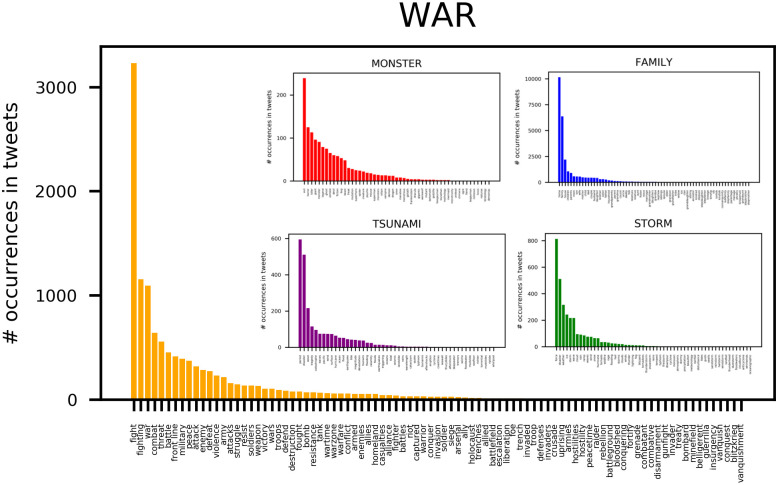
Five histograms depicting the occurrences of terms for each frame within the corpus.